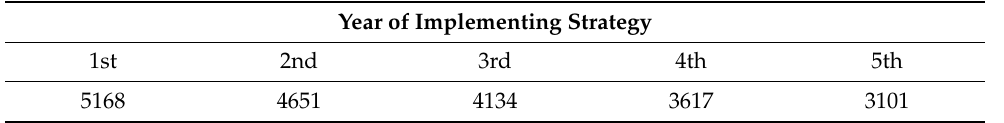
Table 10. Total pollutant emission reduction (PM + SOx, in tons) in five years after Strategy Scrubber is